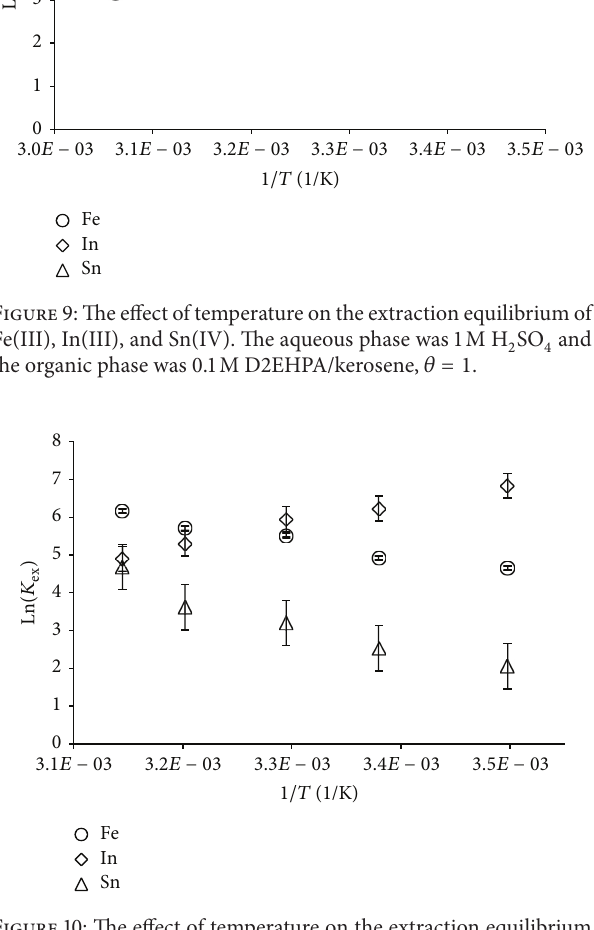
Figure 10: The effect of temperature on the extraction equilibrium of Fe(III), In(III), and Sn(IV). The aqueous phase was 0.1M HCl and the organic phase was 0.1M D2EHPA/kerosene, 𝜃 = 1 . Table 4: Δ ∘ 𝐻 and Δ ∘ 𝑆 for extraction from 1M H obtained by linear fitting of (1).